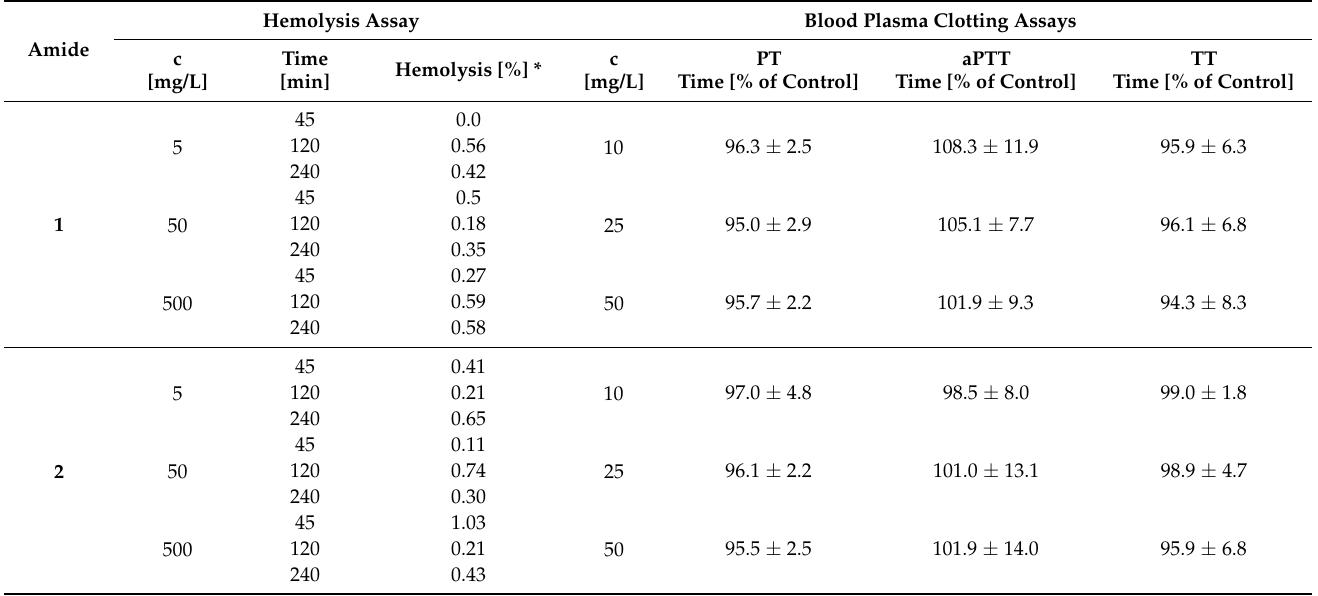
Table 2. Summary of the hemolysis assay and blood plasma clotting assays for amides 1 – 8 .